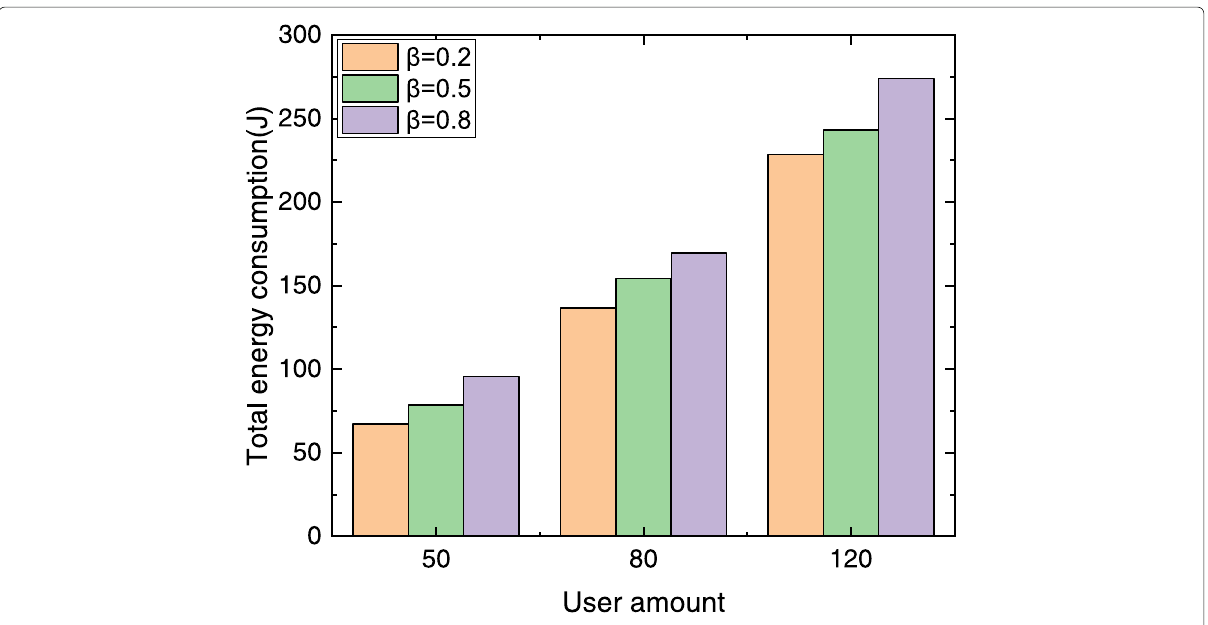
Fig. 11 Impact of β on total energy